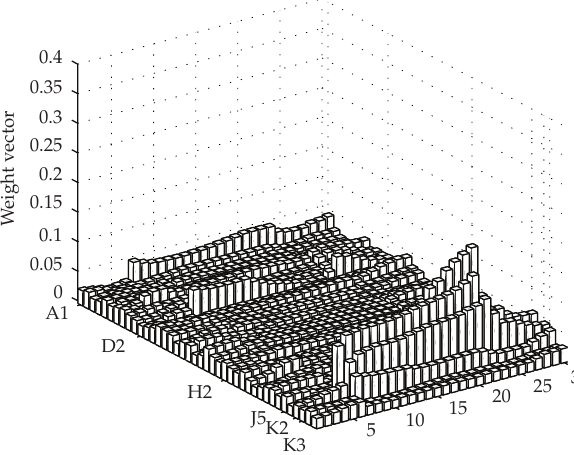
Figure 2: The pattern of P2P tra ffi c, calculated by complete information. For each peer in the group A1, D2, J5, K2, and K3, rate (cid:8) 25, starting time (cid:8) 125 (cid:4) X (cid:8) (cid:4) 125 ∗ 2–200 (cid:5) ∗ 0 . 1 (cid:8) 5 (cid:5) . Then peers of D2 leave at t (cid:8) 160 and peers of H2 join in at t (cid:8) 200 (cid:4) X (cid:8) (cid:4) 200 ∗ 2–200 (cid:5) ∗ 0 . 1 (cid:8) 20 (cid:5) with rate (cid:8) 35.